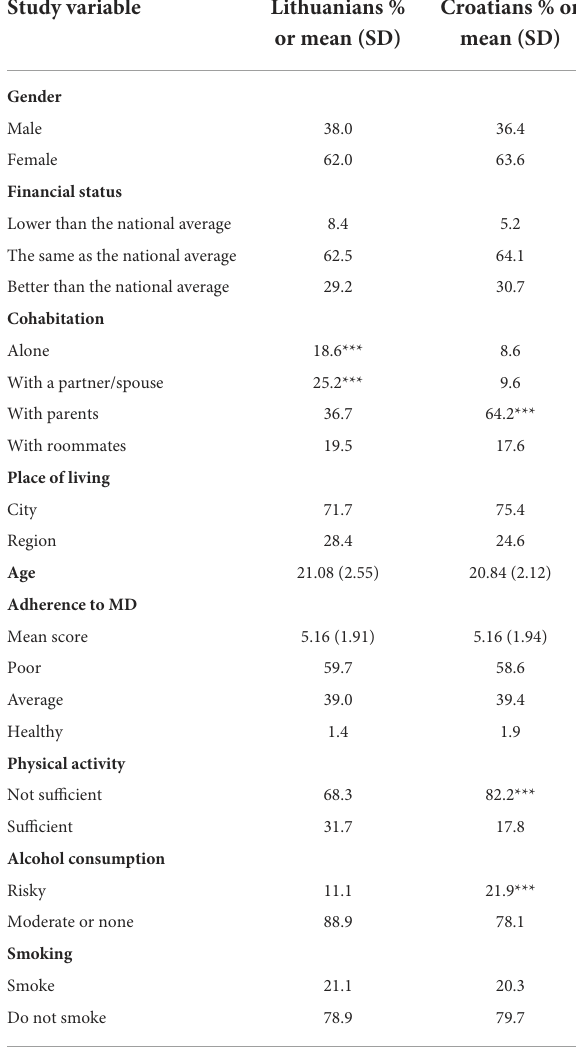
TABLE 1 Sociodemographic and health-behavior characteristics of the study sample. Study